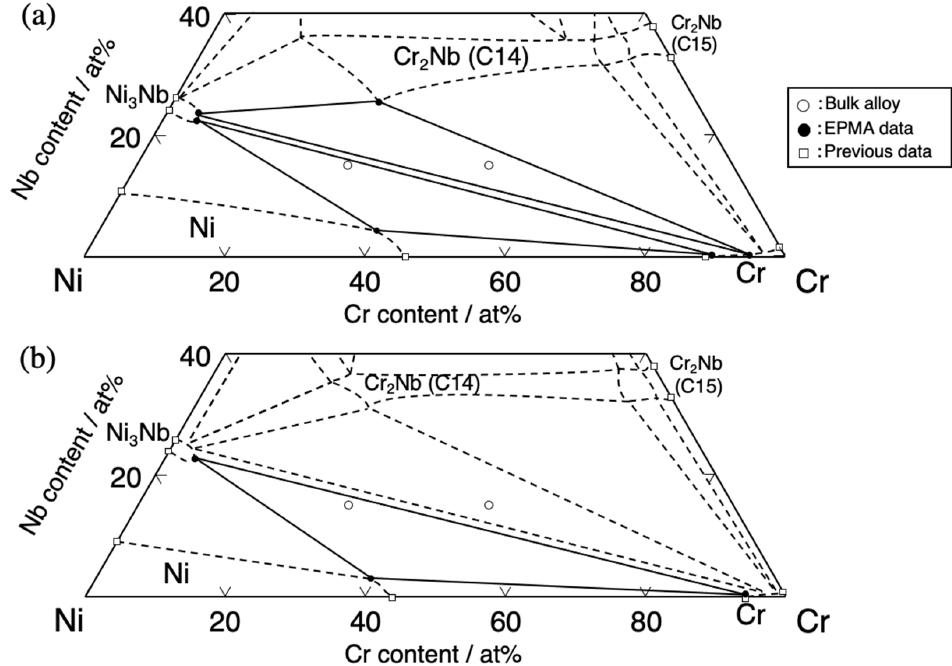
Figure 5. Isothermal section of the Ni–Nb–Cr ternary system: ( a ) 1373 K and ( b ) 1273